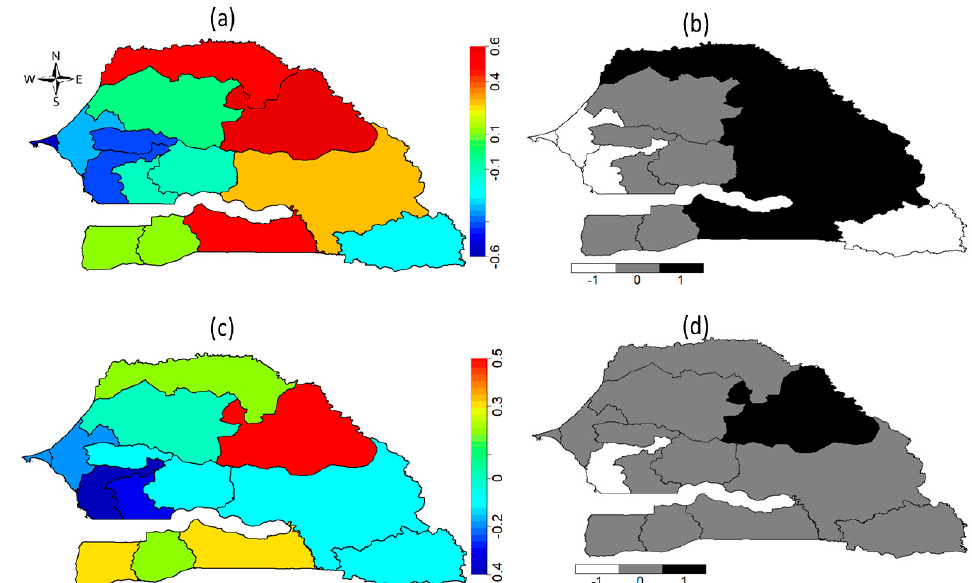
Figure 6. ( a ) Posterior risk map and ( b ) 95% posterior significance map based on Model 5; ( c ) Posterior risk map and ( d ) 95% posterior significance map based on Model 6. Deep blue to red corresponds to low risk to high risk. Black colour indicates significantly high-risk regions, white colour indicates significantly low risk regions and grey colour indicates non-significant regions. Evidence from the pooled 2010 to 2017 SDHS.